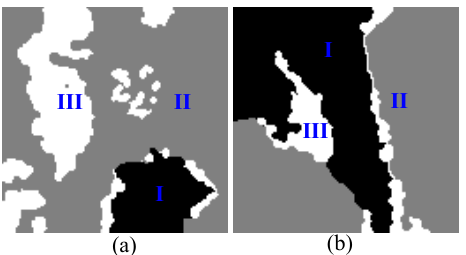
Figure 7. Templates of real SAR images: (a) coastal image, and (b) estuary